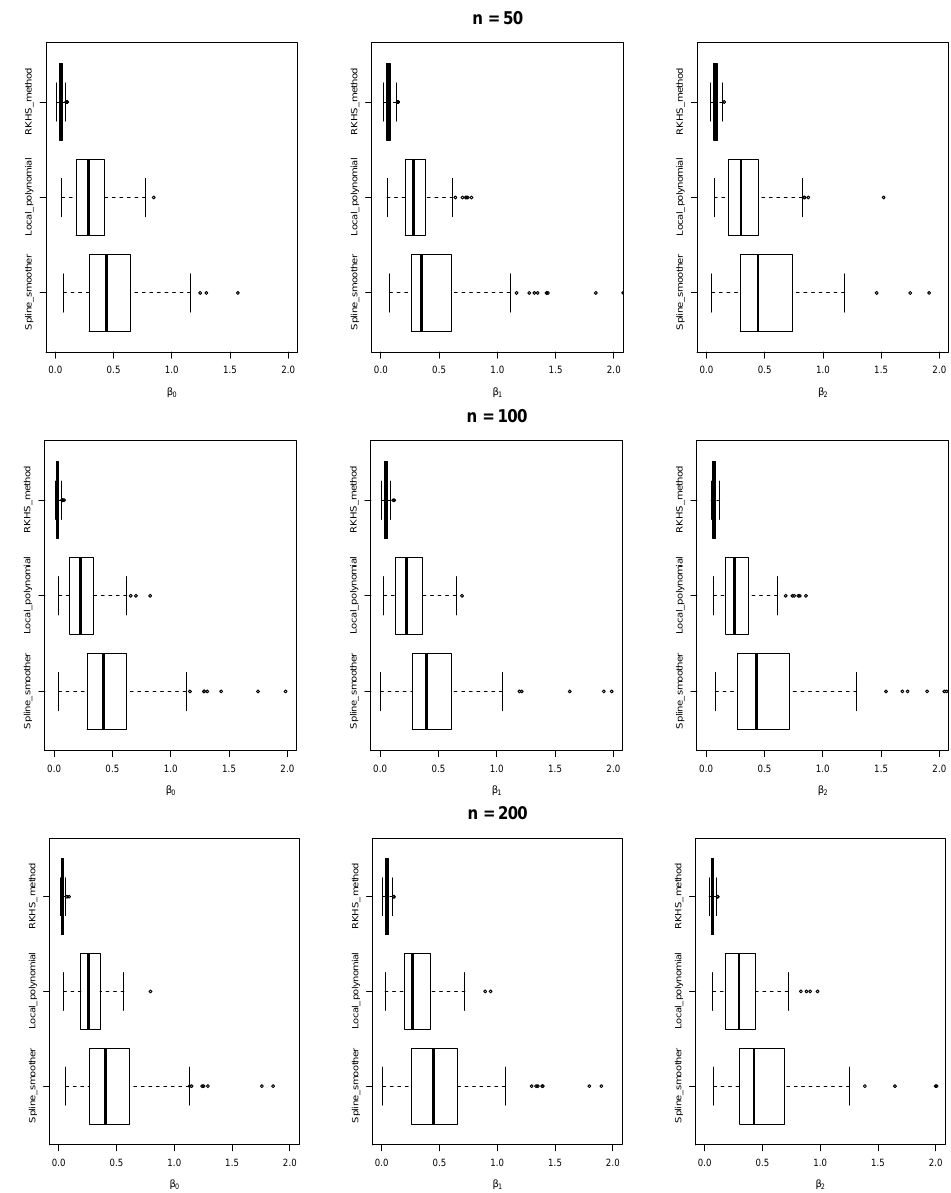
Figure 5. Boxplots of the RIMSPE values. The first row corresponds to sample size 50, the second row corresponds to sample size 100, and the third row corresponds to sample size 200. In each row, the left panel is for estimating β 0 ( t ) , the middle panel is for estimating β 1 ( t ) , and the right panel is for estimating β 2 ( t )